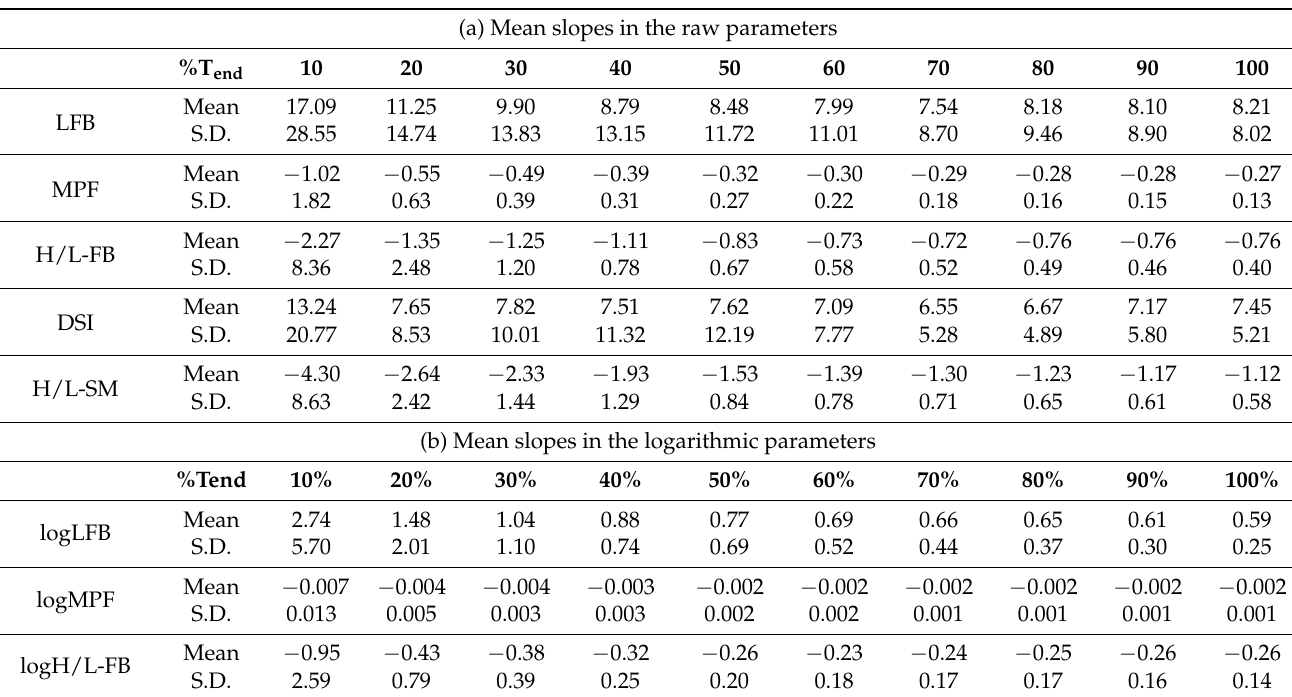
Table 4. Slopes (mean and S.D.) in the sEMG raw parameters (a) and logarithmic ones (b) with respect to time as estimated over every 10% of T end (S.D.: standard